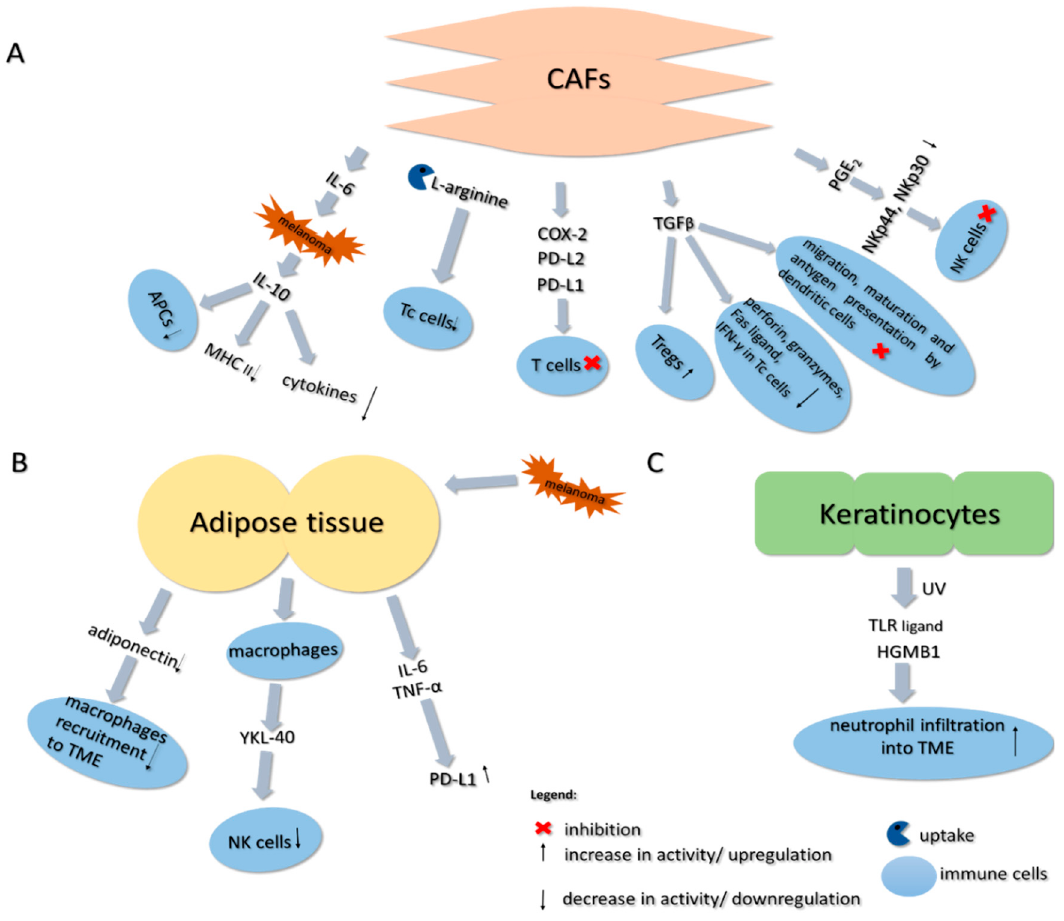
Figure 2. Influence of cancer-associated fibroblasts ( A ), adipose tissue ( B ), and keratinocytes ( C ) on the activity of immune cells present in the melanoma niche. A detailed description is provided in